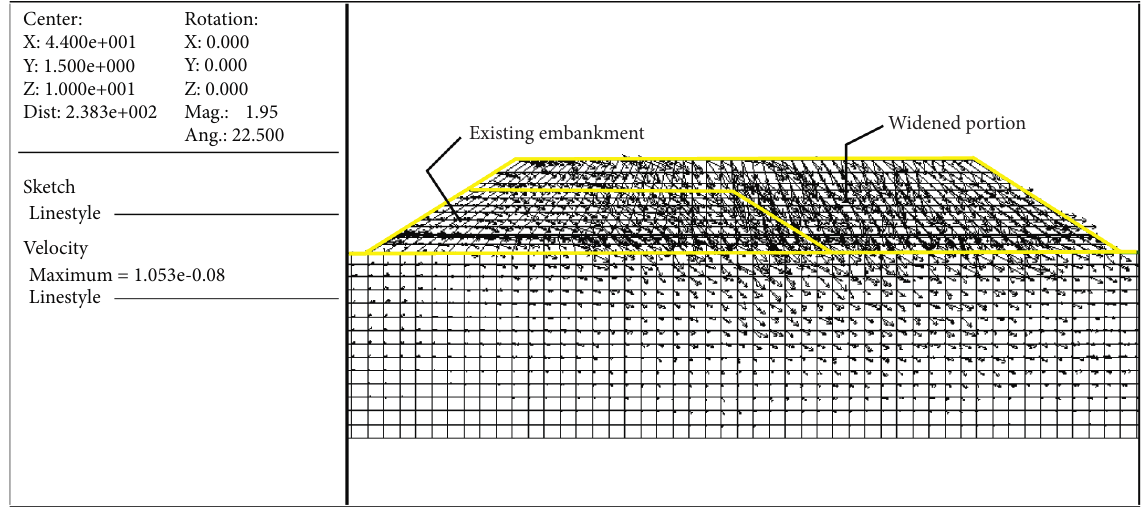
Figure 8: The particle velocity vector